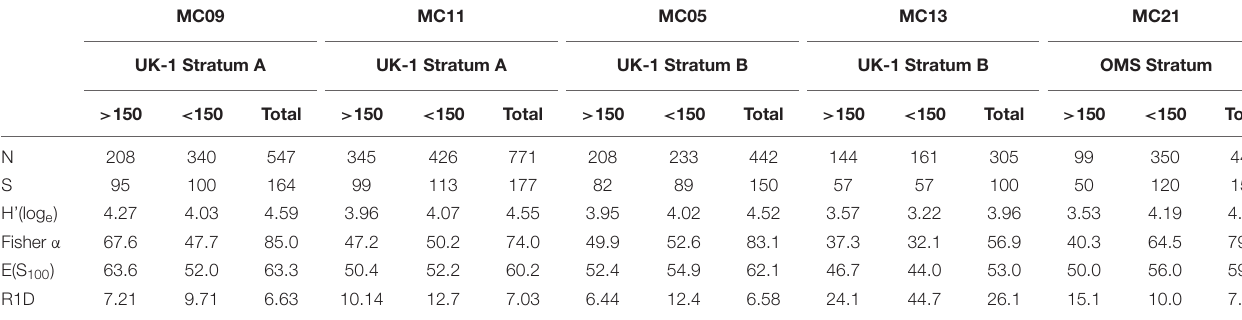
TABLE 7 | Diversity metrics for the stained + dead assemblage in different samples.